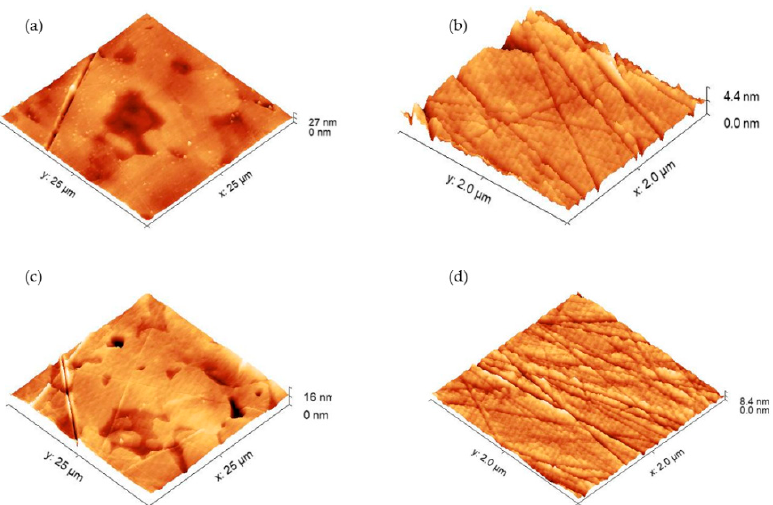
Figure 1. AFM topographical images of Ti6Al4V ELI’s surface prepared according to procedure B (( a , b ) scanning scale equal to 25 × 25 µ m 2 and 2 × 2 µ m 2 , respectively) and procedure C (( c , d ) scanning scale equal to 25 × 25 µ m 2 and 2 × 2 µ m 2 , respectively).